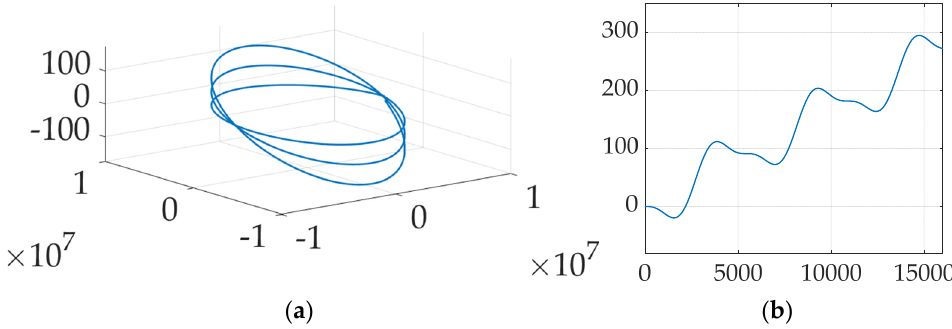
Figure 4. Effect of electrodynamic tether reboost on a 300 km altitude orbit. ( a ) Trajectory. ( b ) Altitude change in meters on ordinate versus time on abscissa.